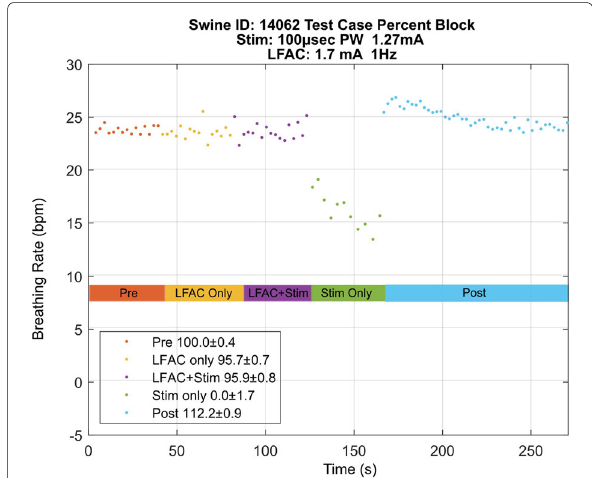
Fig. 5 Breathing rate during each epoch of the experimental paradigm. The percent block is shown in the legend on the bottom left ( ± standard deviation). The ’Pre’ epoch was normalized to 100% block and the ’Stim Only’ epoch was normalized to 0% block. The overshoot seen in the first few seconds of the ‘Post’ epoch is likely due to sympathetic rebound before returning to baseline